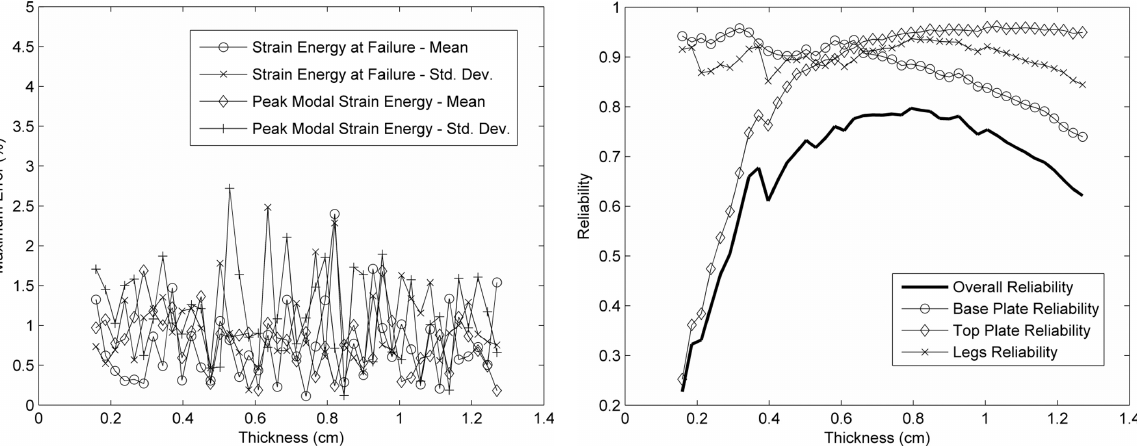
Fig. 12. Percentage difference between nominal values and actual val- ues from Monte Carlo analysis of means and standard deviations of peak modal strain energies and modal strain energies at failure.